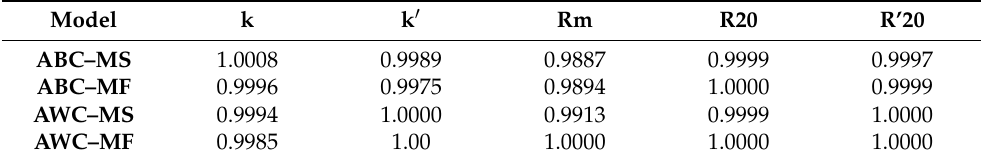
Table 8. Results of external validation.